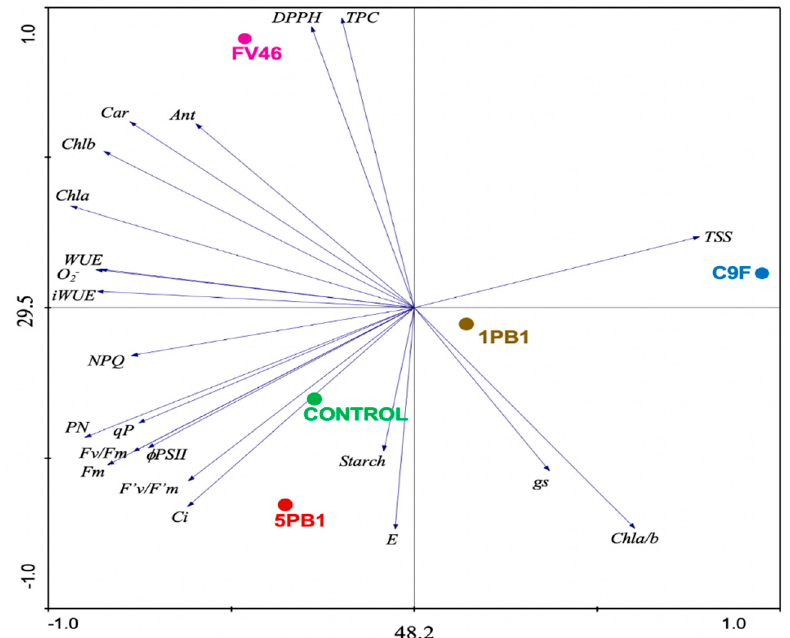
Figure 6. Principal component analysis biplot of the effects of inoculation of the isolates 1PB1, 5PB1, C9F and FV46 on tomato plants. Loading plot for the first axis PC1 explained 48.2% of the